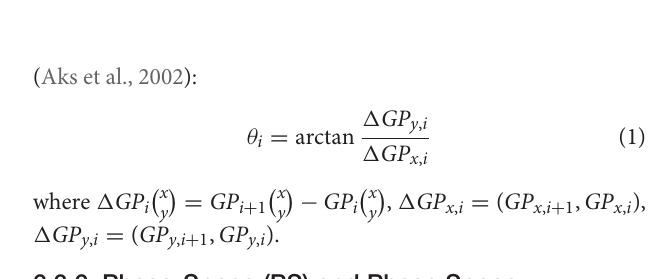
the imagined tasks. Specifically, MC shows the